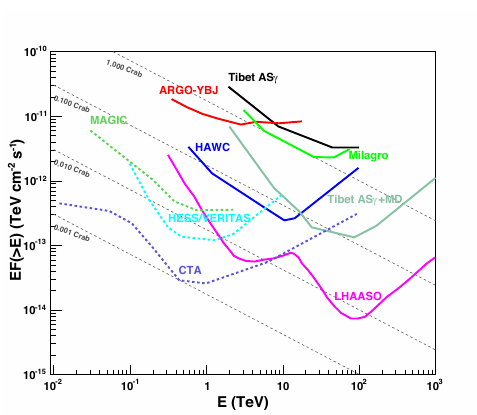
Figure 3. The integrated sensitivity of LHAASO (in pink) com- paring with other experiments. The part of the curve below 10 TeV is the contribution of WCDA optimized with the cuts de- scribed in text.